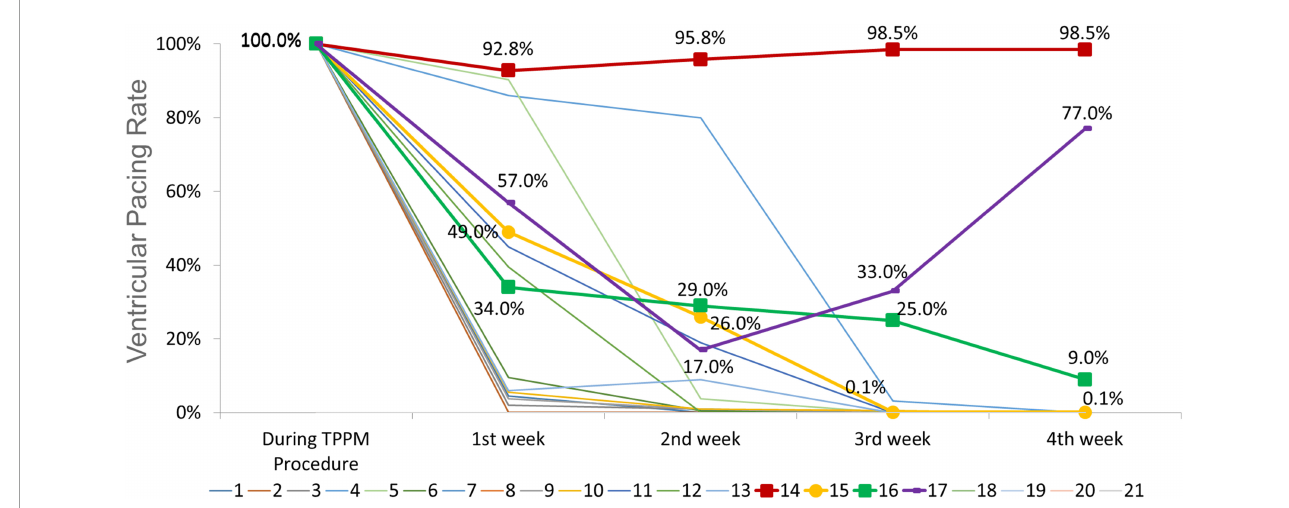
FIGURE3 Trends of ventricular pacing rate during follow up for each individual (central illustration). The ventricular pacing rate (VPR) in patient no. 14 and no. 17 remained high throughout the follow-up period, the electrocardiogram (ECGs) and Holter demonstrated persistent third-degree atrioventricular block (AVB). The VPR decreased from 100 to 0.1% in patient no. 15 and from 100 to 9% in patient no. 16, however, Holter indicated intermittent third-degree AVB. These four patients received permanent pacemaker (PPM). For other 11 patients, the VPR decreased to 0%, and the ECGs and Holter revealed no indication for PPM. For patients with 1st degree AVB and left bundle branch block (LBBB), the VPR remained 0% throughout follow up.